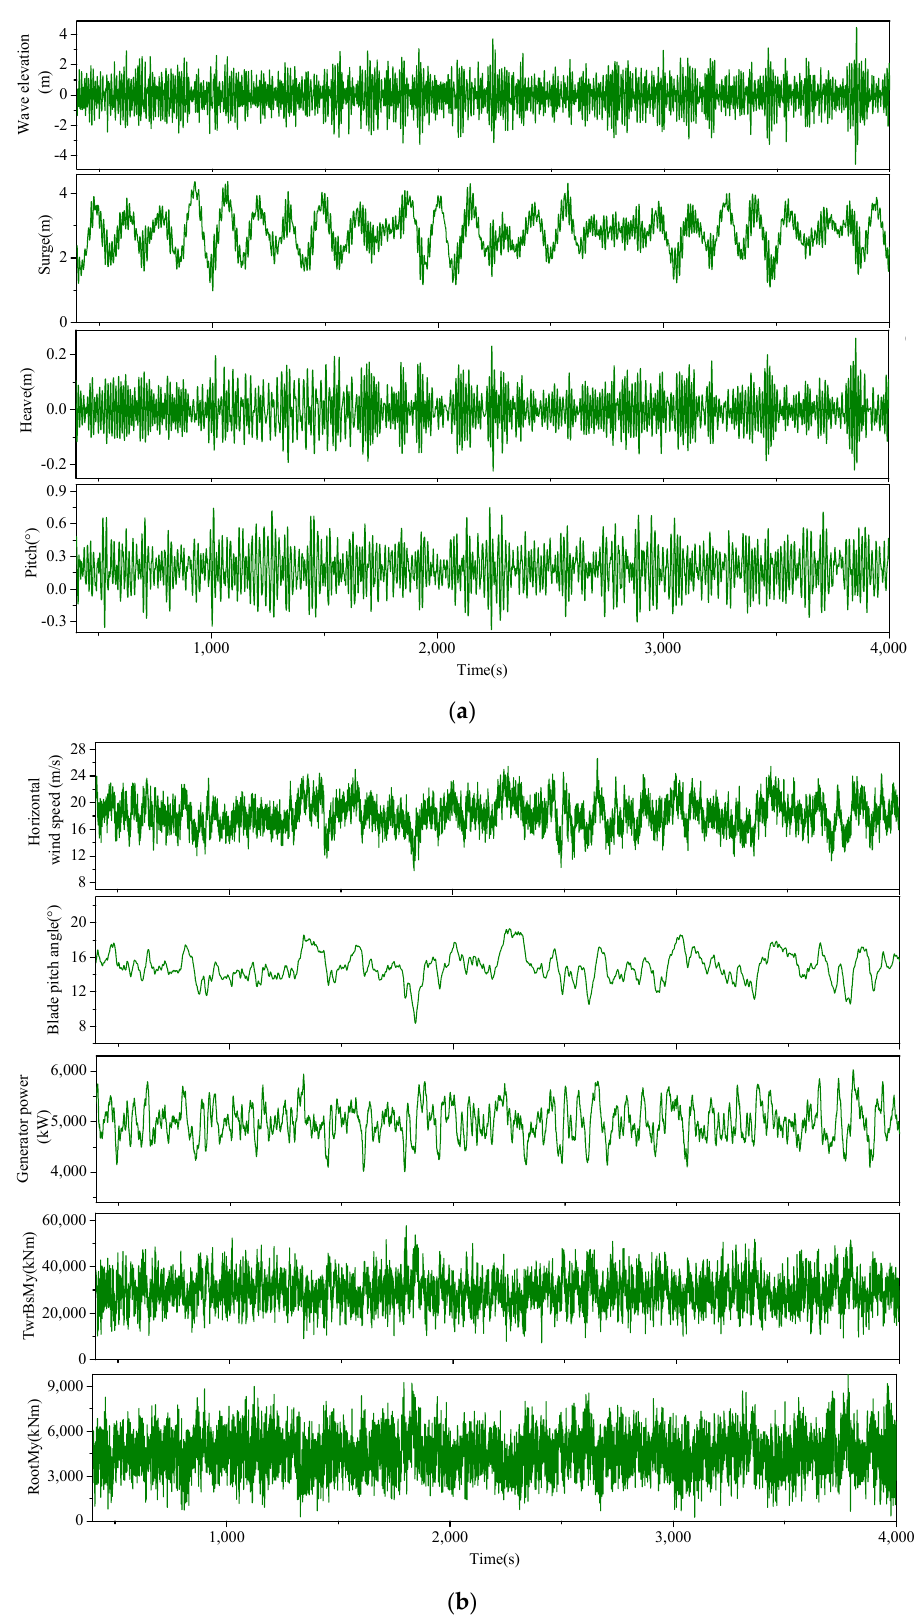
Figure 15. Time histories of responses of the cage and wind turbine under condition 3. ( a ) Cage responses. ( b ) Wind turbine